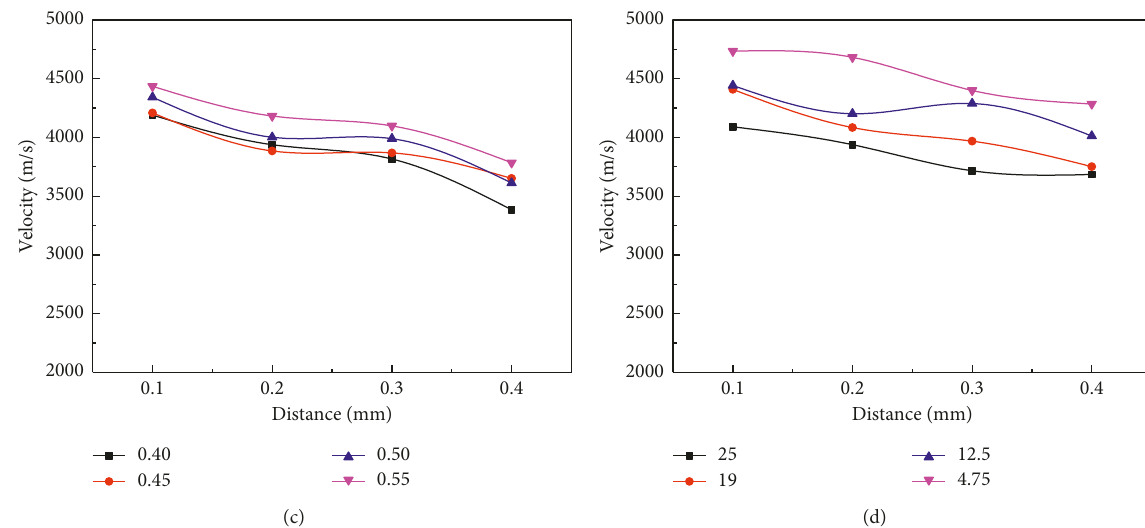
Figure 4: AE velocity with different distances under the same water-cement ratio and different aggregate sizes. Water-cement ratio is (a) 0.4, (b) 0.45, (c) 0.5, and (d) 0.55.